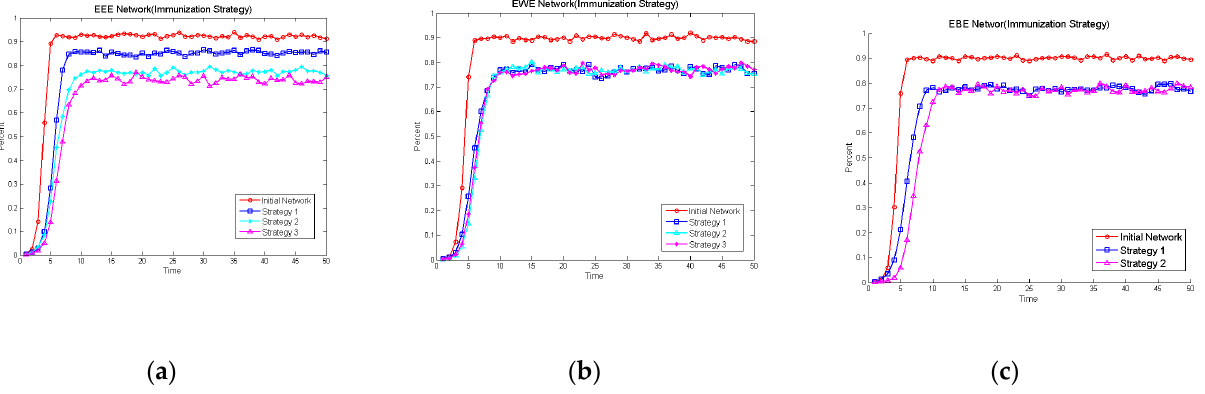
Figure 13. Immunization strategy based on three networks. ( a ) the immunization strategy based on three-layer EEE network; ( b ) the immunization strategy based on three-layer EWE network; ( c ) the immunization strategy based on three-layer EBE network.